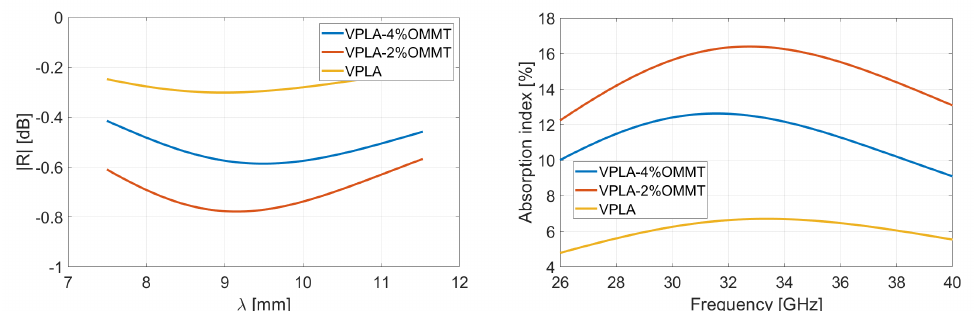
Figure 9. Simulation of reflectivity and absorption performances for virgin PLA–OMMT nanocom- posites in Rozanov configuration. The thickness of films is set at 1.4 mm.